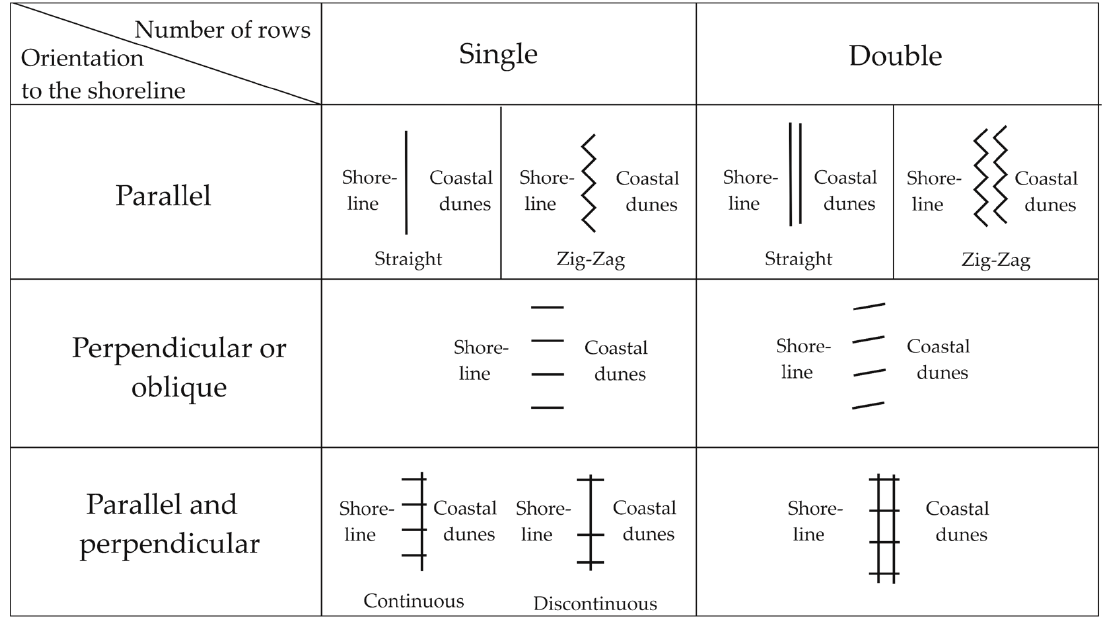
Figure 3. Frequently installed configurations of coastal sand trapping fences (adapted from [44]).